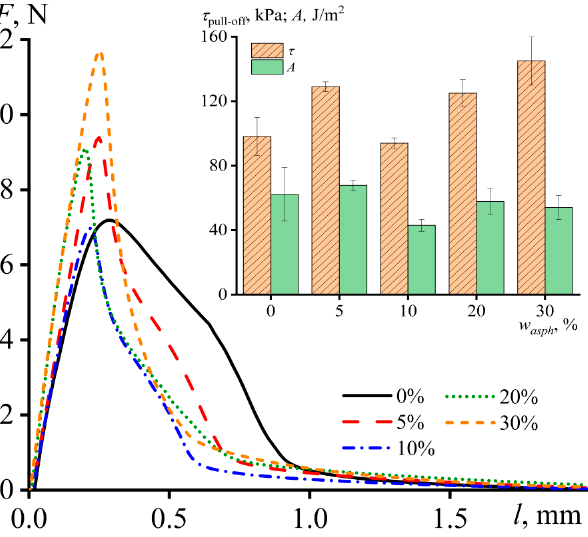
Figure 8. Load–displacement curves for probe-tack tests of PIB and its mixtures containing a different mass fraction of asphaltenes at 25 °C. The insert demonstrates the dependences of the debonding energy and the apparent strength of adhesive joints on the asphaltene content.